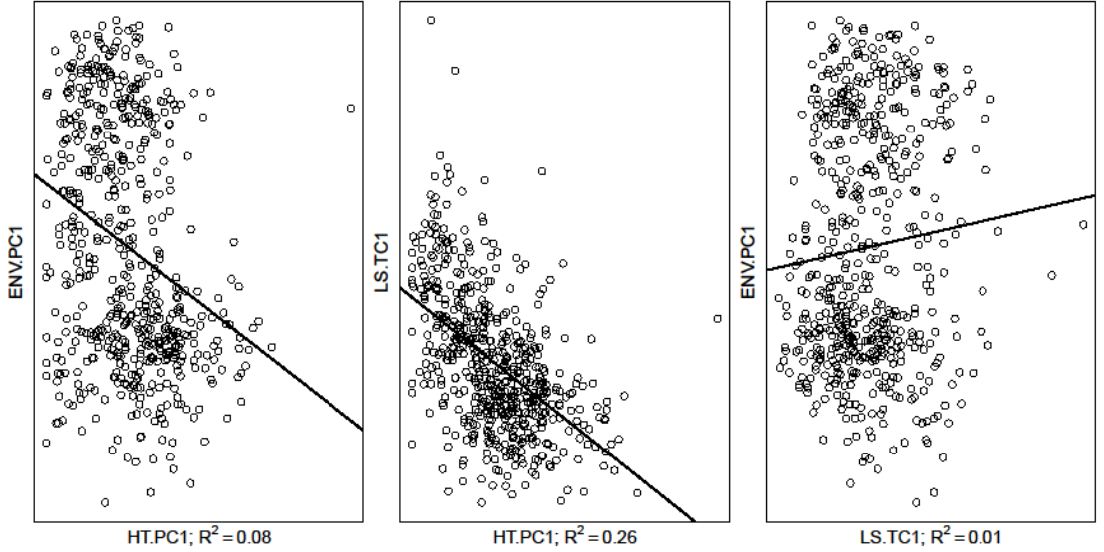
Figure 4. Scatterplots and coefficients of determination (R 2 ) of first principal components for Landsat (LS), DAP Height (HT), and environmental gradients (ENV). The black is an OLS fit between variables on x and y axes.